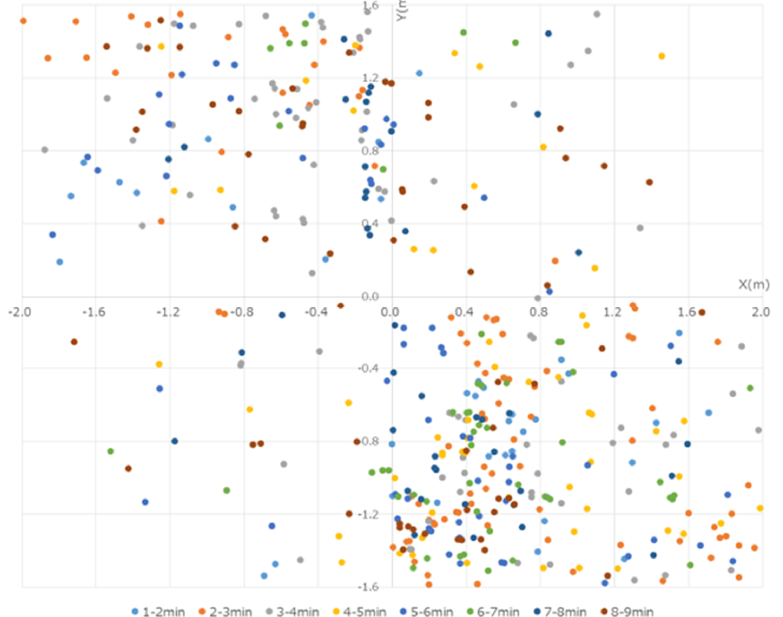
Figure 4. Quantity of particles measured every 30 s with the P/Cs. Immediately after the start of the experiment, many particles were in the 50 cm range around the workers. The particles were distributed westward. By 120 s, the quantity of particles measured at each location reached a similar amount, and the particles spread out in the room over